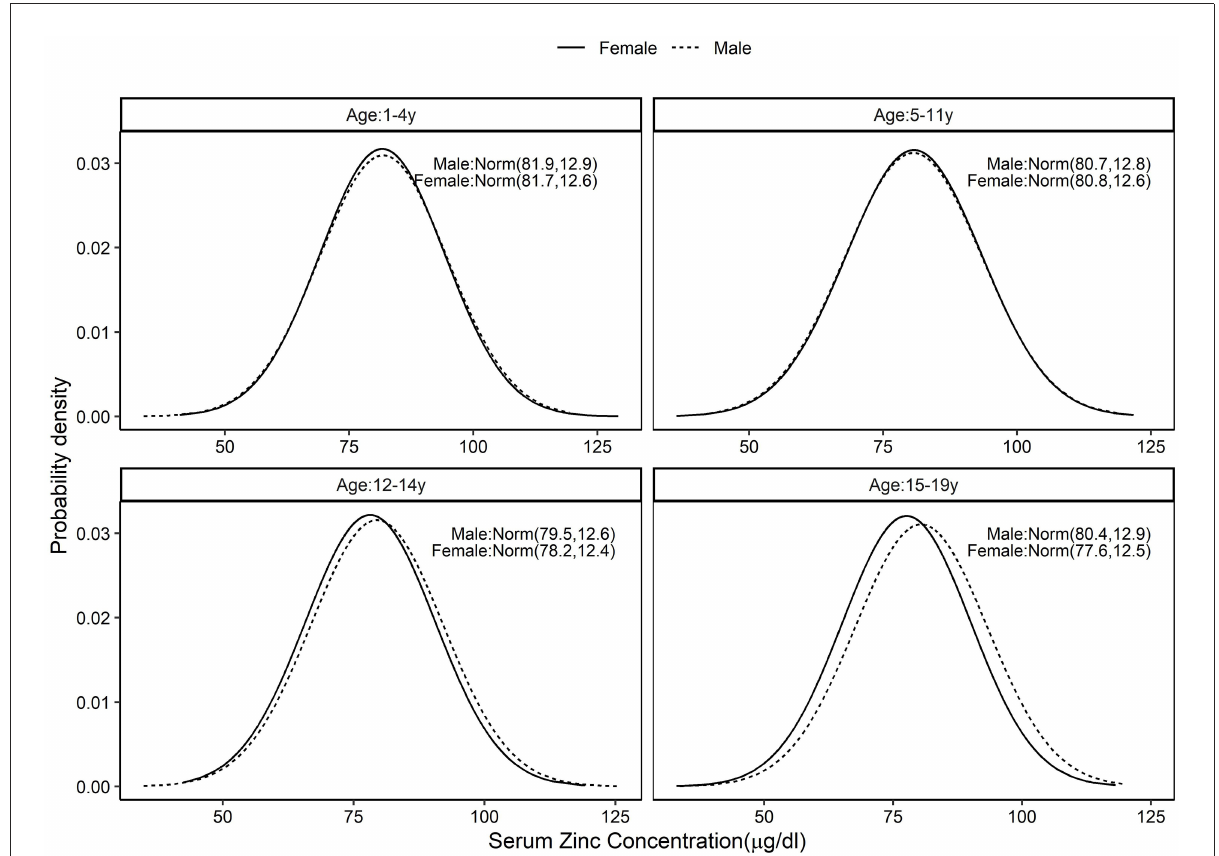
FIGURE2 Standard distribution of serum zinc ( µ g / dL ) concentrations among healthy Indian children aged 1–4, 5–11, 12–14, and 15–19 years; Solid line represents Female children and dotted line represents Male children. Values given in parenthesis are mean and SD of normally distributed serum zinc in µ g / dL